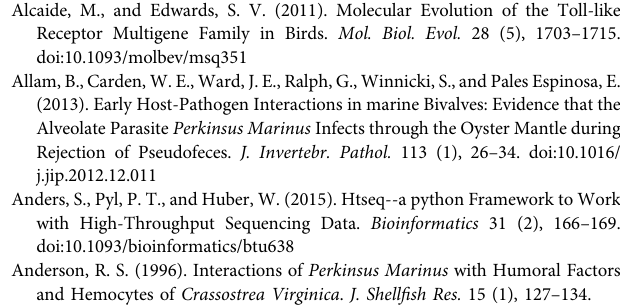
Supplementary Figure 1 | Domain structure of galectin (LOC111130470, Top) and its upregulation (Bottom) under P. marinus challenge in C. virginica . Supplementary Figure 2 | Phylogenetic tree and positive selection analysis of the TLRs from the largest tandem repeat cluster in C. gigas. No positively selected branch or site was detected among these TLRs. Supplementary Figure 3 | Volcano plots of transcriptional changes under short- term and long-term P. marinus challenge in C. gigas. Blue points represent downregulated genes, red points represent upregulated genes, and black points represent non-differentially expressed